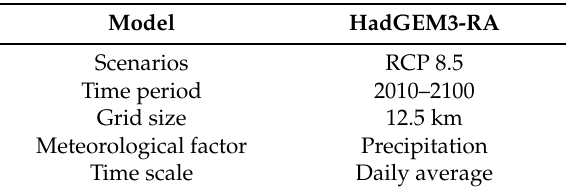
Table 1. NIMR climate change scenario data.